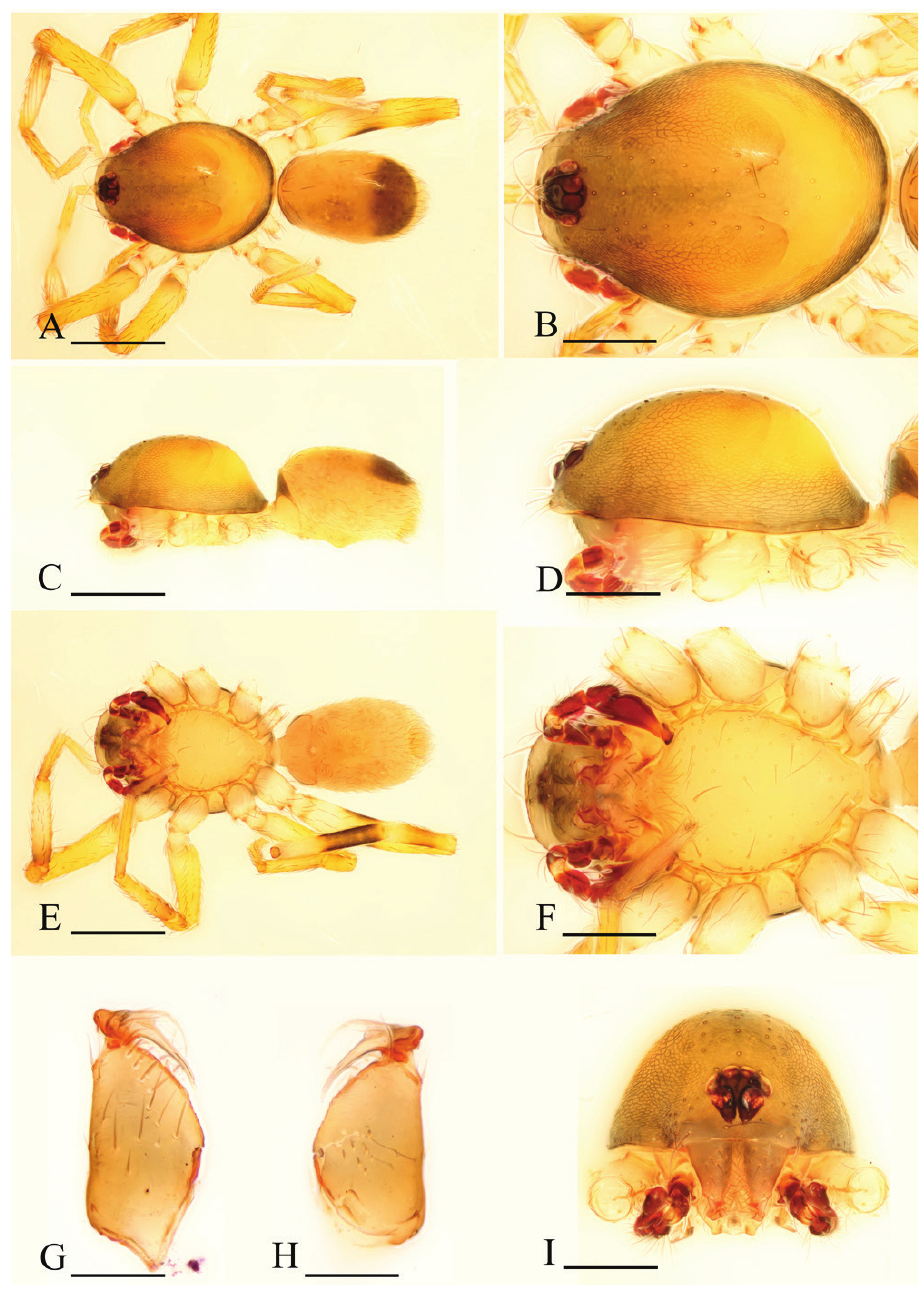
Figure 7. Ischnothyreus dactylinus sp. n., male. A, C, E habitus, dorsal, lateral and ventral views B, D, F, I prosoma, dorsal, lateral, ventral and anterior views G, H left chelicera, anterior and posterior views. Scale bars: A, C, E = 0.4 mm; B, D, F, I = 0.2 mm; G, H = 0.1